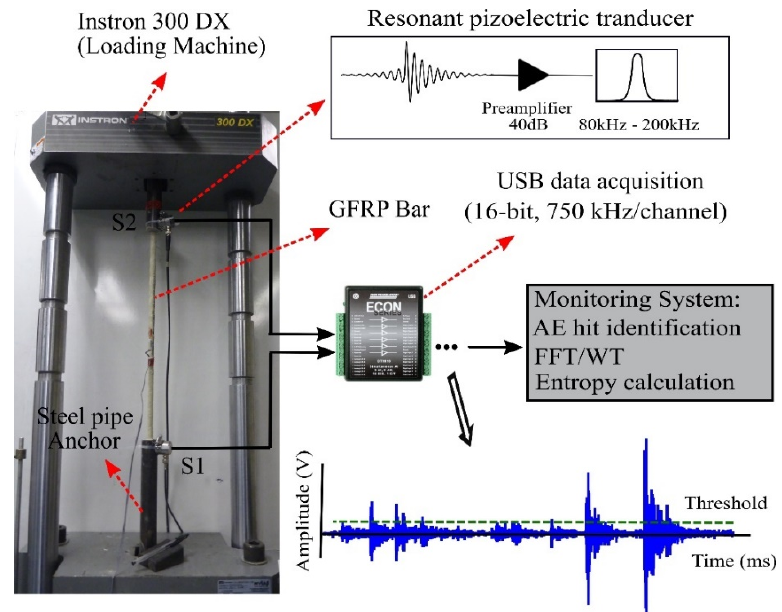
Figure 4. A schematic of the FRP tensile test .